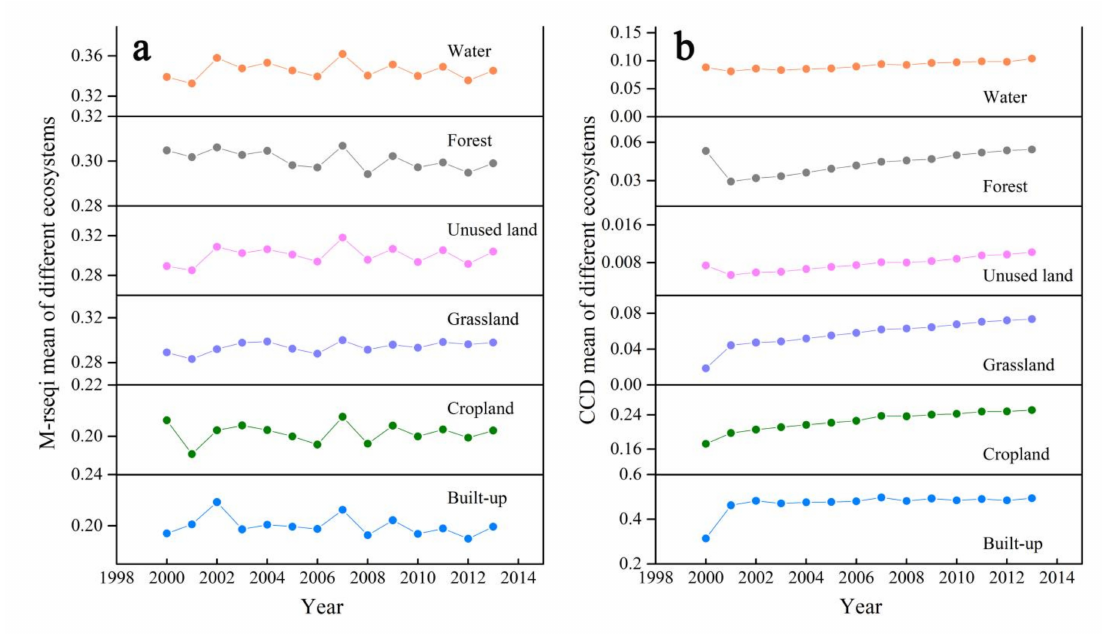
Figure 5. Annual changes in the ( a ) M-RSEQI and ( b ) CCD in China in different ecosystems from 2000 to